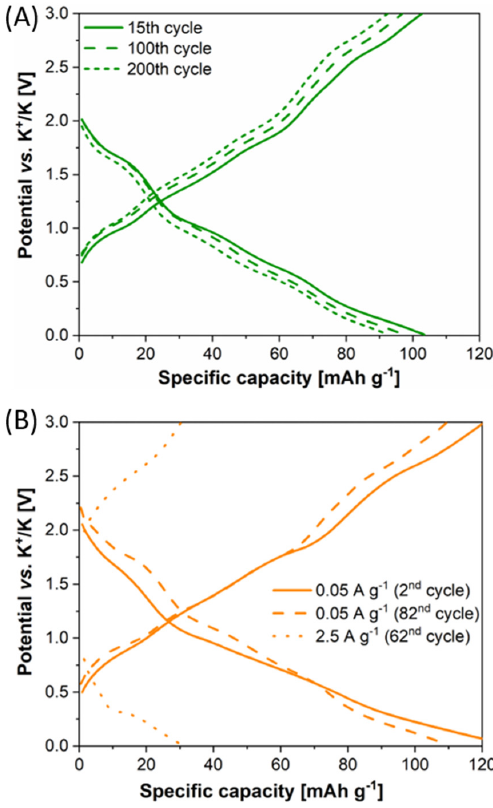
Figure 2. Potential vs. specific capacity profiles for a coin cell based on the MoS 2 anode: ( A ) Data collected at cycles no. 15, 100 and 200 and at a current density of 0.1 A g –1 ; ( B ) Data collected at different current regimes and cell life.